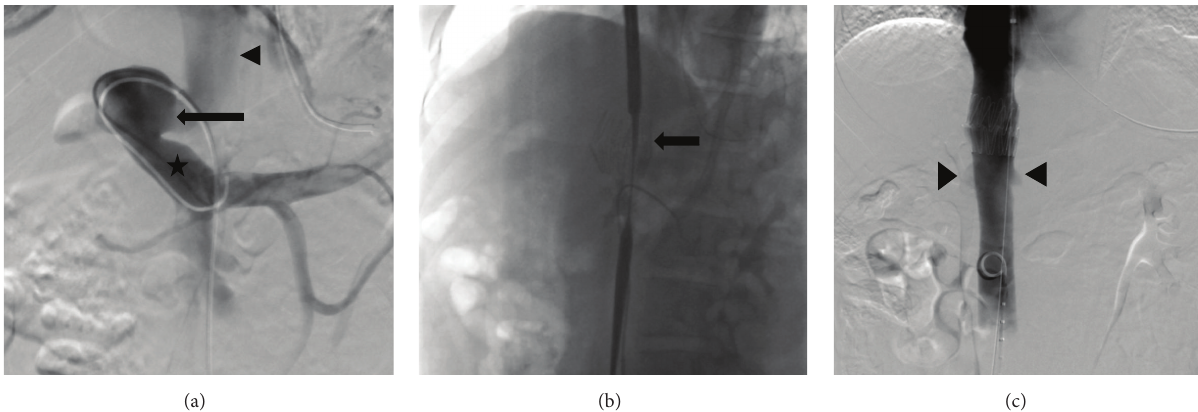
Figure 1: (a) Digital subtraction angiography of a type 2 Abernethy malformation. Injection of contrast into the splenic vein revealed marked flow of contrast into a patent portal vein (star), the portosystemic shunt (horizontal arrow), and the IVC (arrowhead). (b) Fluoroscopic placementofaorticendograftwithintheIVC.Introductionoftheaorticendograft(arrow)intotheIVCoccludedthecommunicationbetween the portosystemic shunt and systemic venous system. Care was taken not to occlude the renal or hepatic veins. (c) Postprocedure cavagram. Digital subtraction venography demonstrates a patent inferior vena cava after endograft placement at T12-L1. The inferior aspect of the graft can be visualized in satisfactory position superior to the renal vein inflow bilaterally